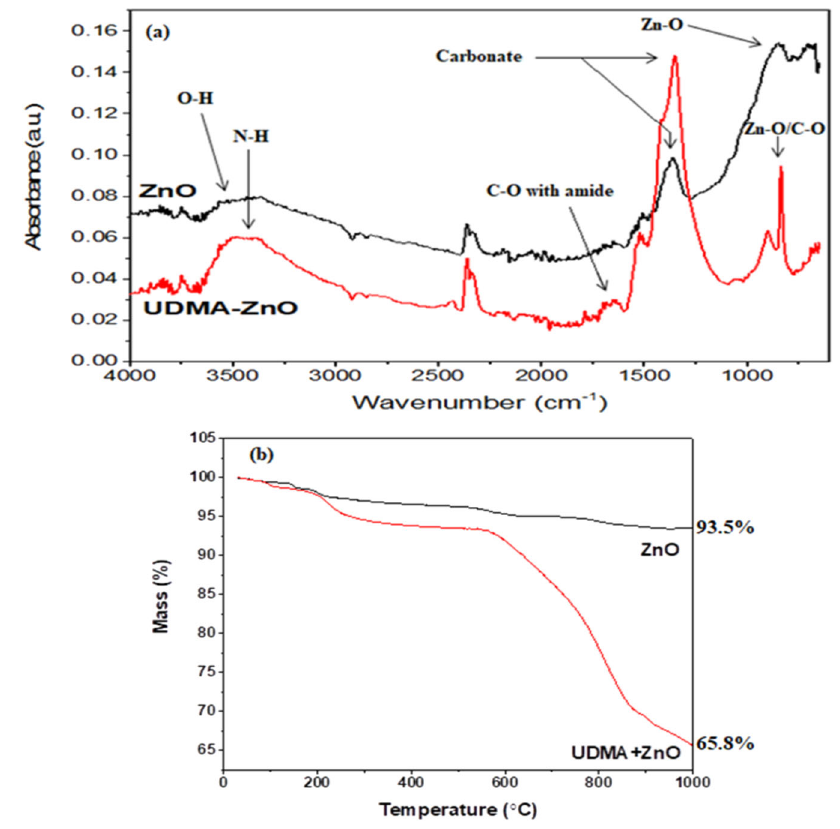
Fig. 1 a FTIR spectra of UDMA-grafted and nongrafted ZnO particles b TGA graph of pure and UDMA-grafted ZnO showing the mass loss after heating at 1000 °C